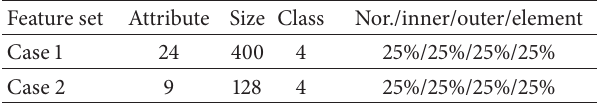
Table 3: Feature sets.